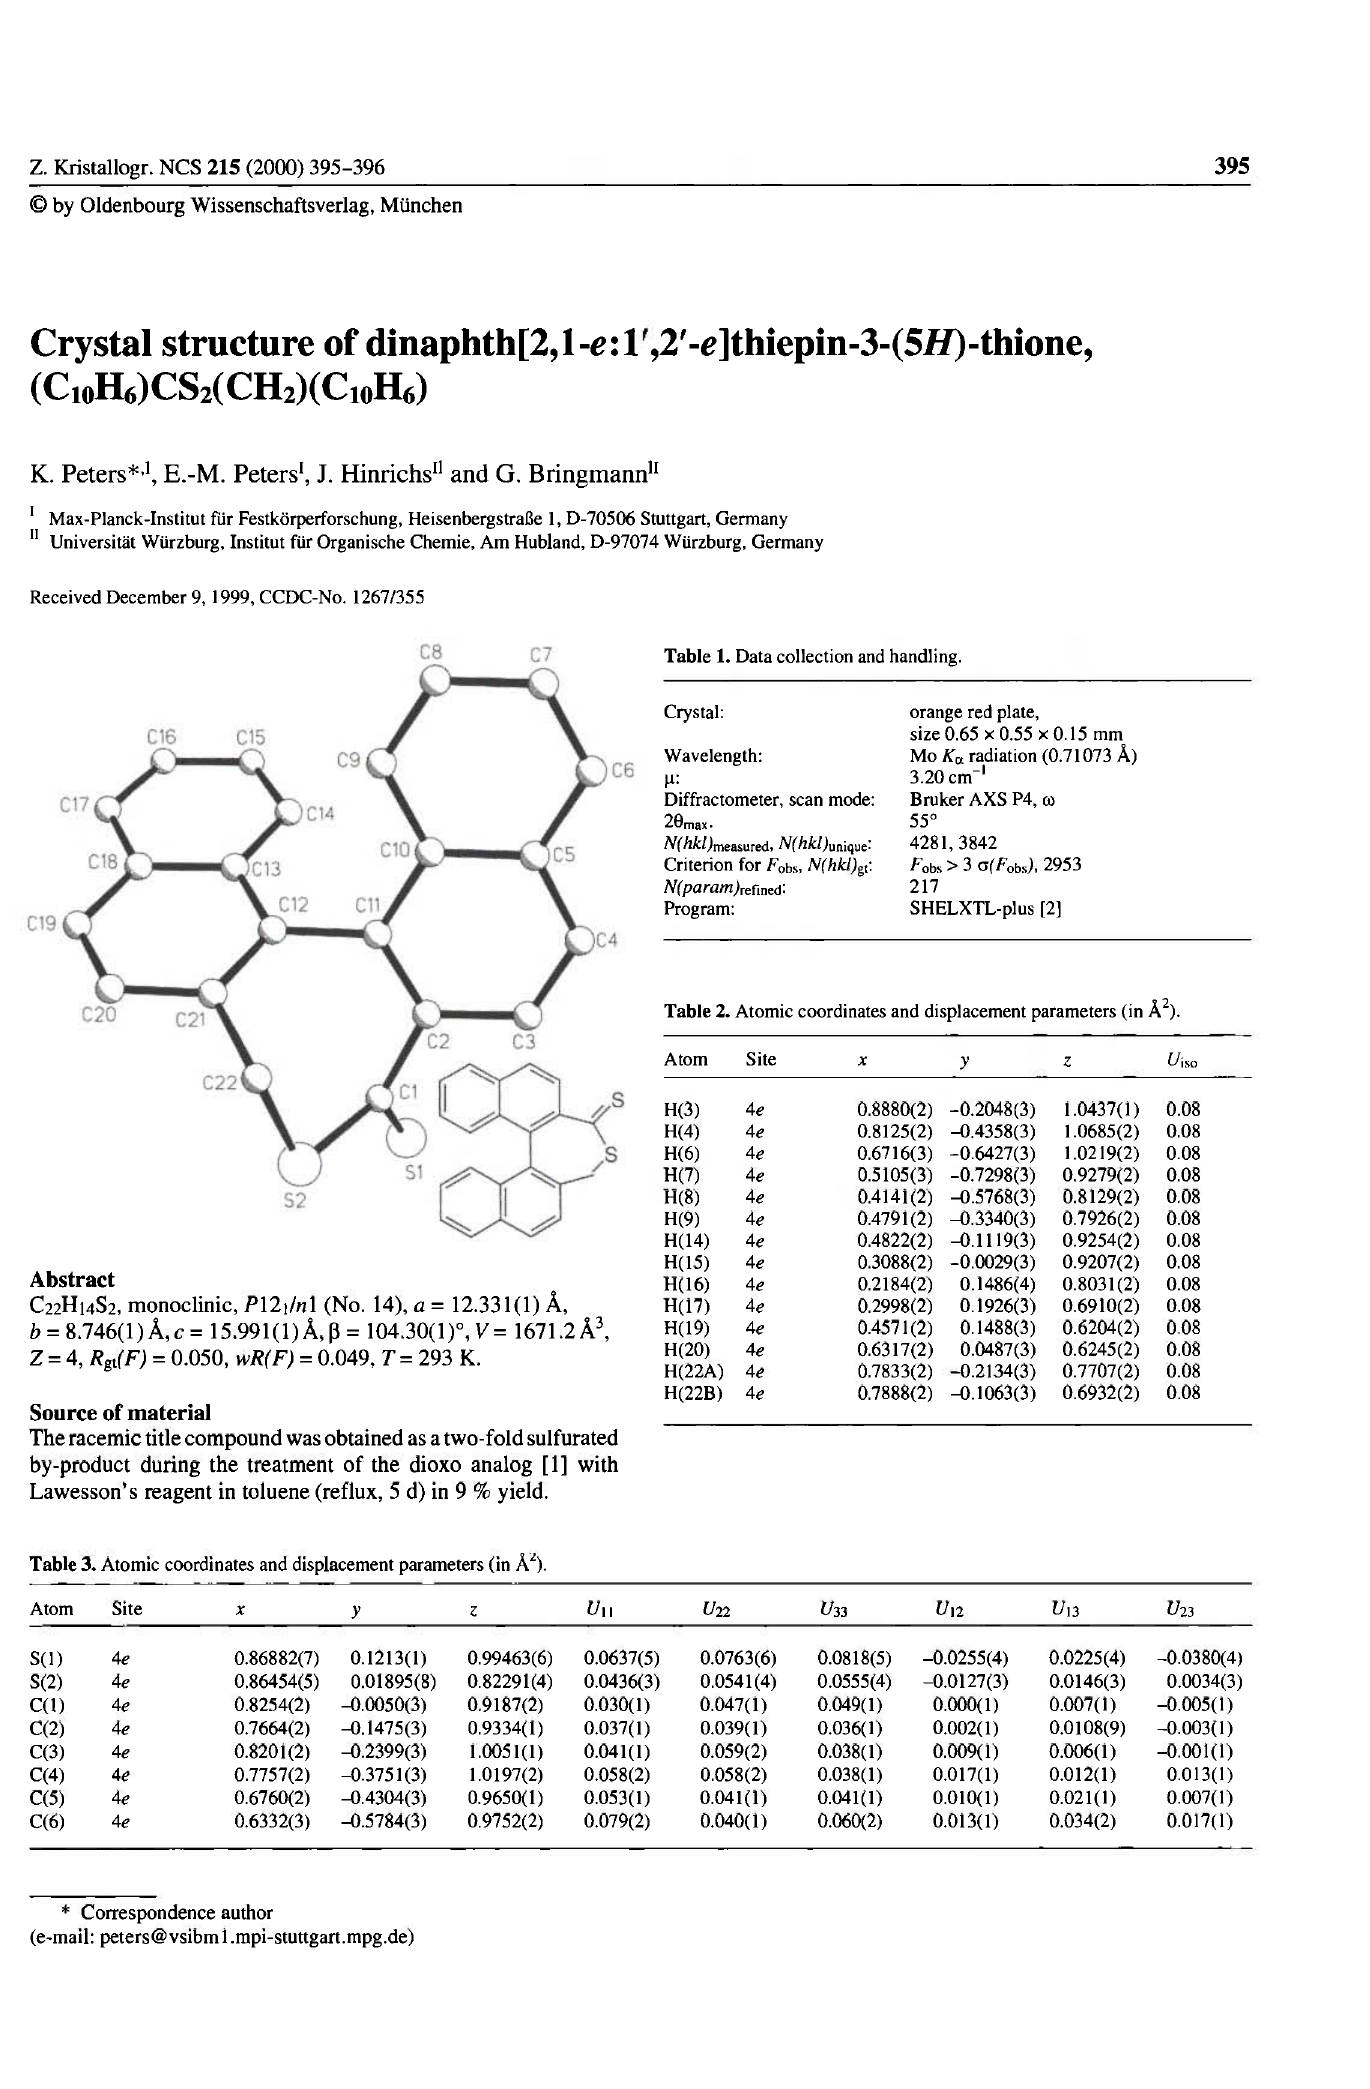
Table 3. Atomic coordinates and displacement parameters (in Ä